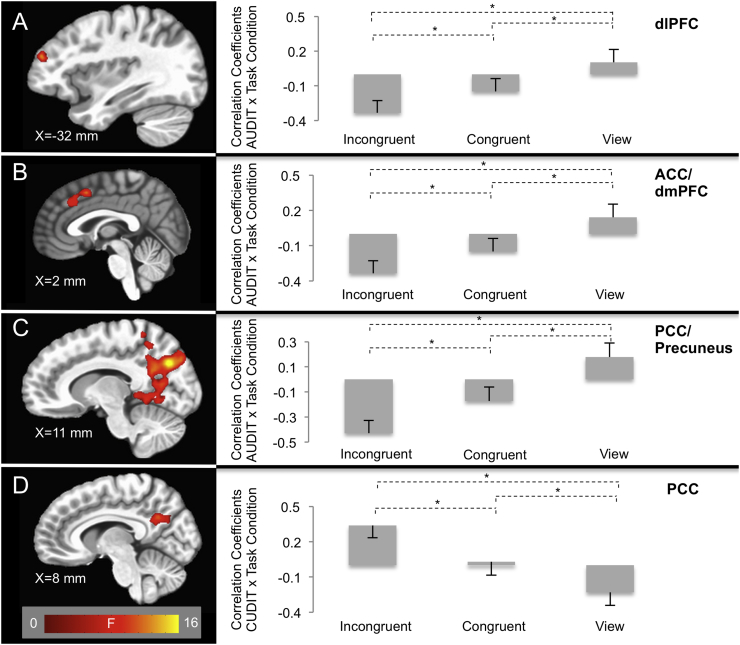
AUDIT-by-task condition interactions within the (A) dlPFC (x = 26 mm, y = 35 mm, z = 44 mm); (B) ACC/dmPFC (x = 2 mm, y = 11 mm, z = 44 mm); and (C) PCC/Precuneus (x = 11 mm, y = −67 mm, z = 29 mm). Participants with higher AUDIT scores showed decreased responses in these brain regions during incongruent trials relative to congruent and view trials. Values in the bar graphs represent the correlation coefficients between AUDIT scores and BOLD response for each task condition within each cluster. CUDIT Score-by-task condition interactions within the (D) PCC (x = 8 mm, y = −52 mm, z = 26 mm). Participants with higher CUDIT scores showed increased responses in these brain regions during incongruent trials relative to congruent and view. Values in the bar graphs represent the correlation coefficients between CUDIT scores and BOLD responses for each task condition within each cluster. * indicates significant differences between partial correlation values (Steiger's Z > 1.96, p < 0.05).